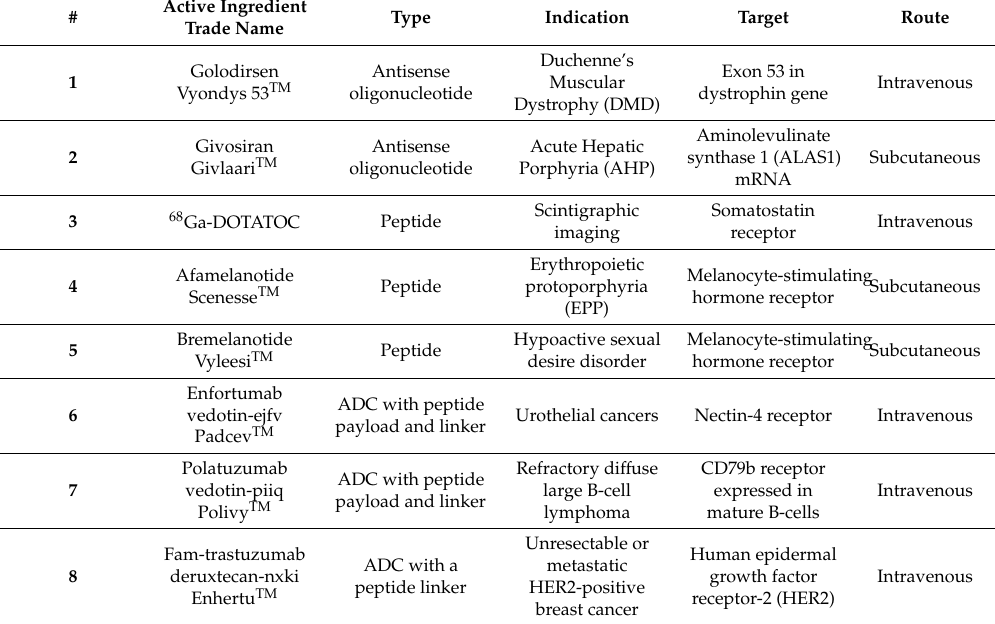
Figure 1. A total of 175 new drugs approved by the FDA from 2016 to 2019 [1–4]. mAbs; Monoclonal antibodies, ADCs; antibody drug conjugates, Oligos; oligonucleotides. Table 1. Summary of the 2019 FDA peptides & oligonucleotides (TIDES) harvest [5].